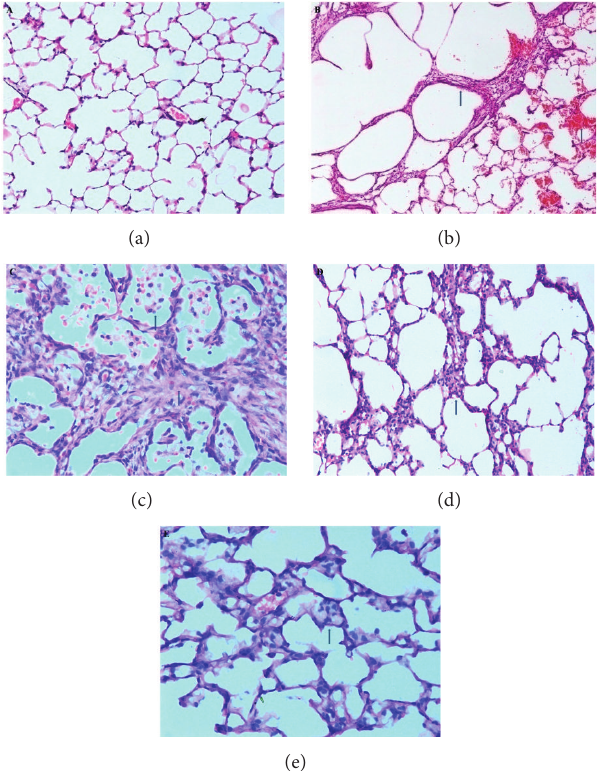
Figure 5: (Hematoxylin and eosin staining.) (a) Normal histoarchi- tectureoflung200x.(b)Bleomycin-treatedlungshowingthickening of alveolar septa with hemorrhages and marked exphysematous change 200x. (c) Bleomycin-treated lung showing severe thickening of alveolar septa with fibroblast proliferation and infiltration of foamy macrophages and mononuclear cells 400x. (d) Quercetin- treated lungs showing mild to moderate thickening of alveolar septa 200x. (e) Quercetin-treated lungs showing mild thickening of alveolar septa with few inflammatory cells